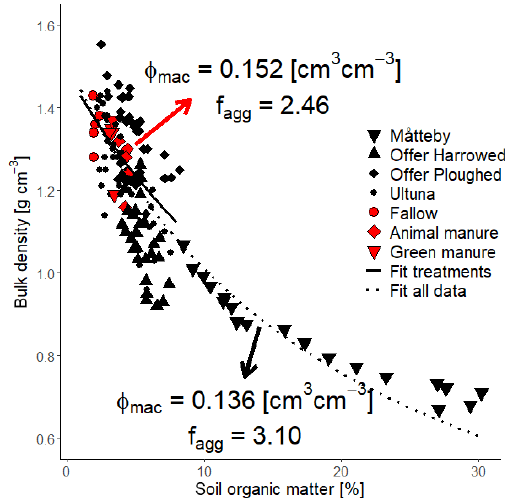
Figure 4. Equation (19) fitted to data from three Swedish field sites. Ultuna data taken from Kirchmann et al. (1994), Gerzabek et al. (1997), Kirchmann and Gerzabek, (1999) and Kätterer et al. (2011). Måtteby data taken from Larsbo et al. (2016), with the soil under grass. Offer data taken from Jarvis et al. (2017); harrowed soil had been ploughed and harrowed (samples were taken at 2–6cm depth) and ploughed soil was only ploughed (samples were taken at 13– 17cm depth). Data used in this study are highlighted in red (fal- low, animal manure and green manure). Soil organic matter con- tent was estimated from soil organic carbon by multiplying by two (Pribyl, 2010). Equation (19) was fitted by non-linear least-squares regression, assuming a priori that γ m = 2 . 7, γ o = 1 . 2gcm − 3 and ø min = 0 . 35cm 3 cm − 3 .